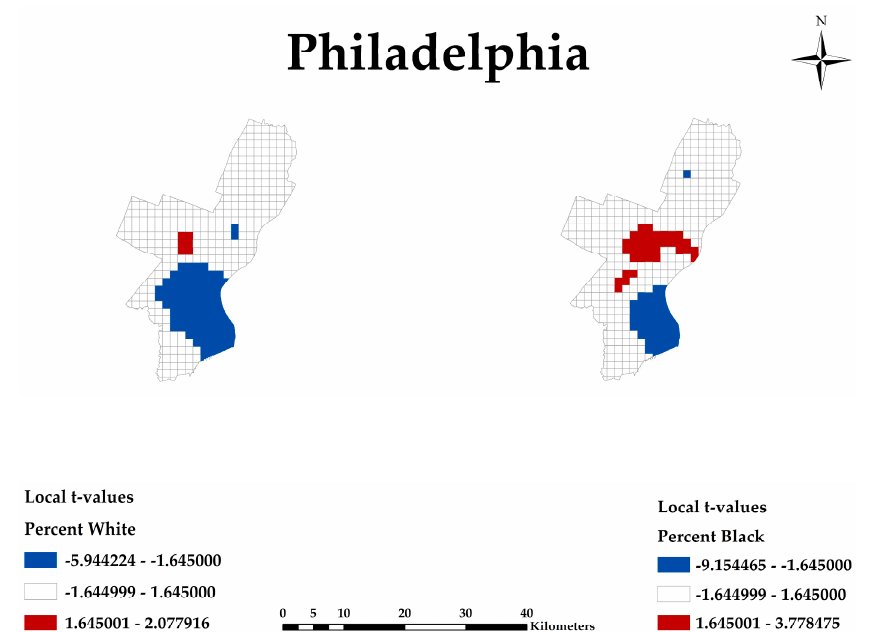
Figure 12. Philadelphia shrinking city Percent White and Percent Black: 95% two-tailed test ( − 1.96:1.96) for 2010.